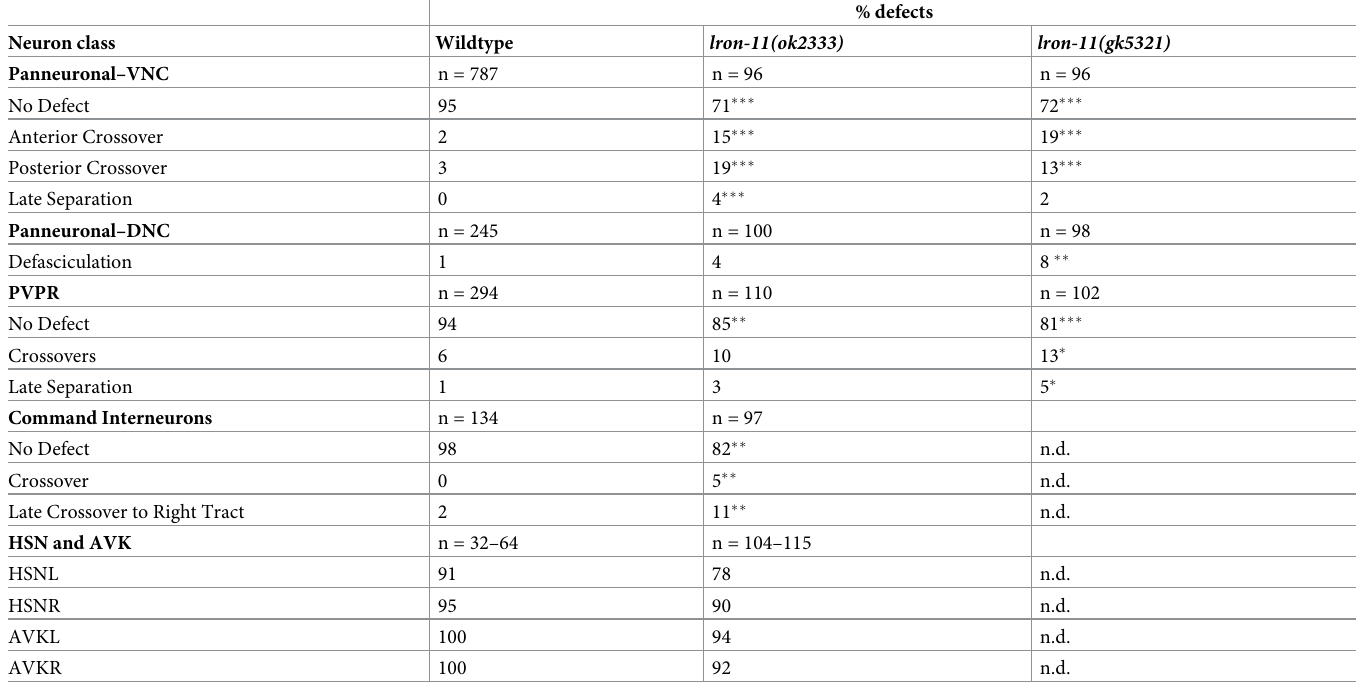
Table 2. Panneuronal and interneuron axon guidance defects in lron-11 mutants.